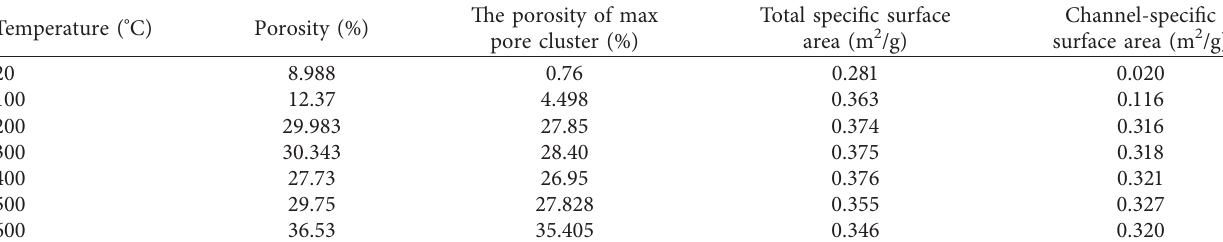
Figure 4: CT scan coal cube images of lignite at different temperature (731 × 731 × 100 voxels).(a) 20 ° C. (b) 100 ° C. (c) 200 ° C. (d) 300 ° C. (e) 400 ° C. (f) 500 ° C. (g) 600 ° C. Table 2: Pore structural parameters of lignite at different